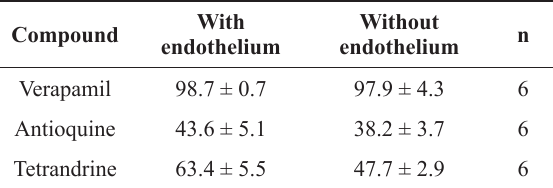
It shows the three compounds studied (tetrandrine, antioquine and verapamil) in rat aorta with (presence of endothelium) and without (absence of endothelium) in phase 1 of the contraction. The effect of tetrandrine and antioquine is is significantly different but the blocking effect of verapamil is almost total.